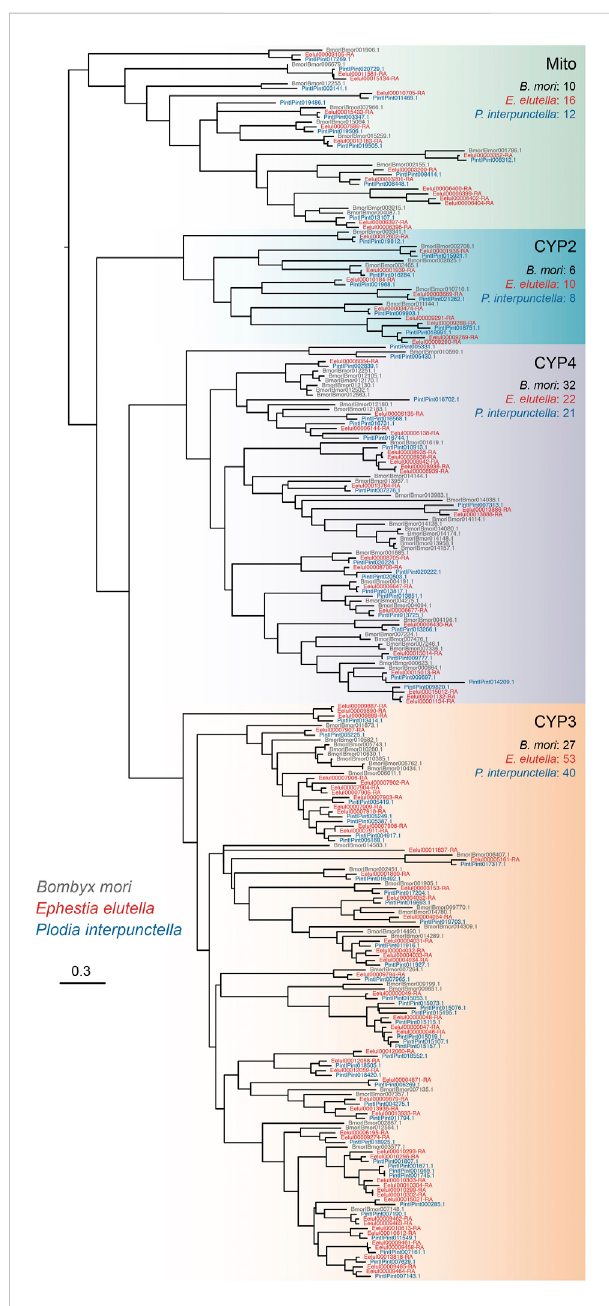
FIGURE 4 Phylogenetic tree of P450 proteins from E. elutella , P. interpunctella , and B. mori . Four main clades of P450s are indicated, and the gene numbers of these three species in each clade are also